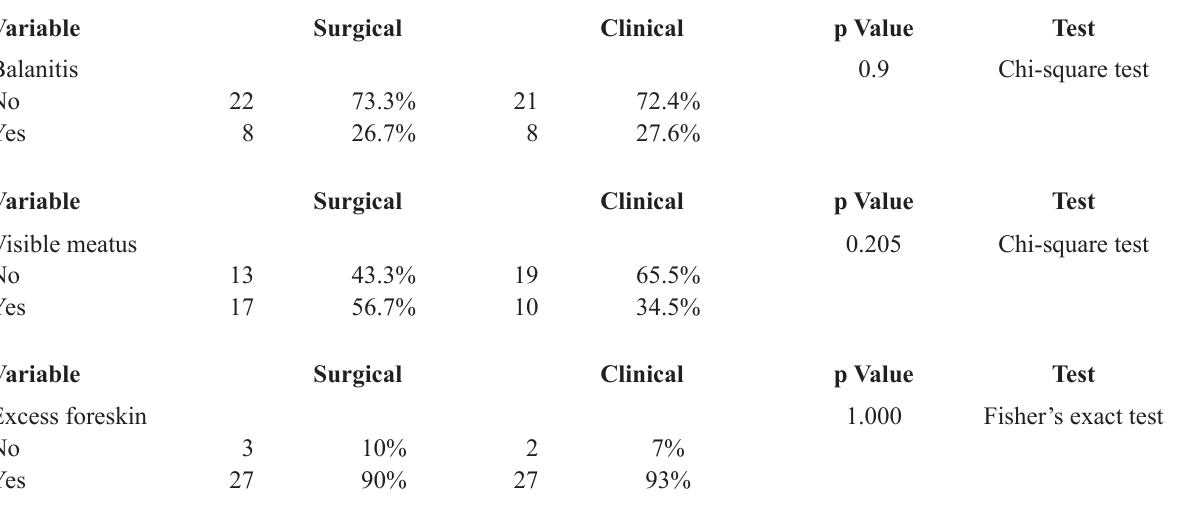
Table 1 – Distribution of clinical findings regarding the incidence of balanitis, exposure of the urethral meatus and excess